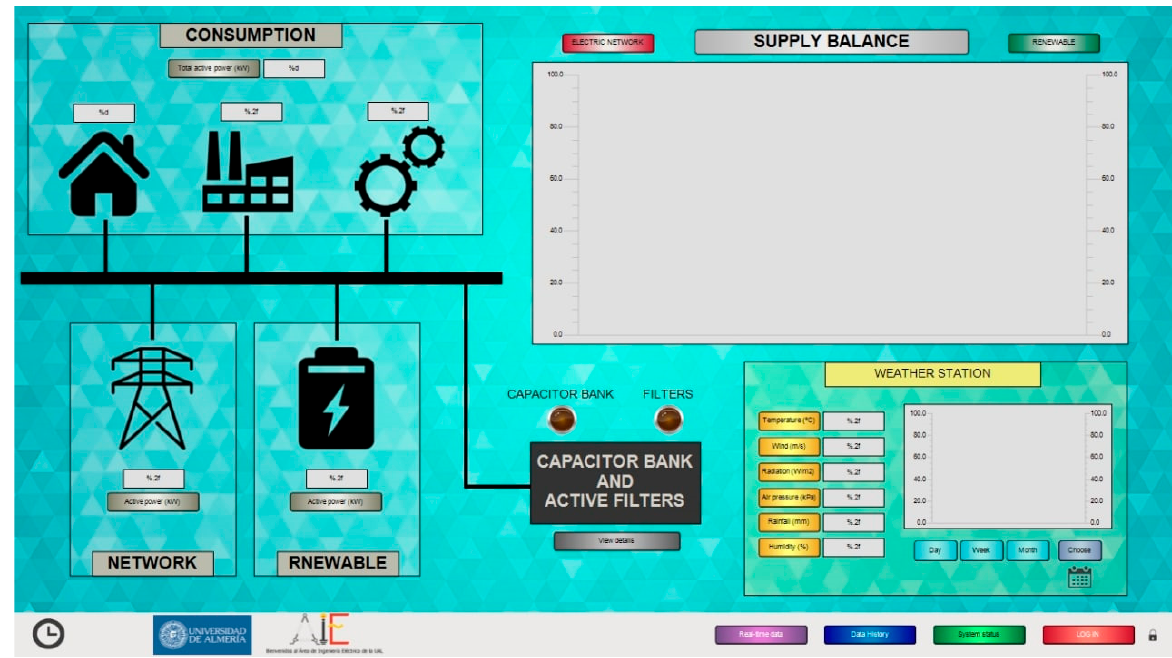
Figure 5. Main view of the